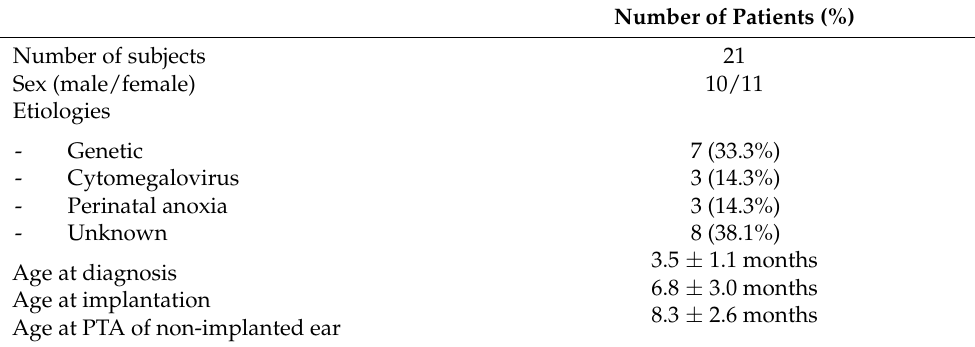
Table 2. Demographics and clinical data of implanted subjects.